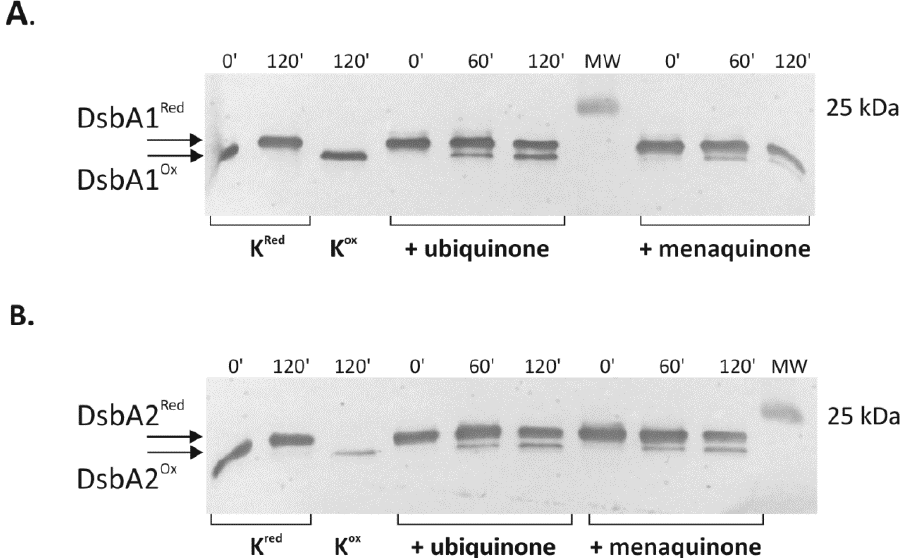
Figure 11. Western blot analysis of the CjDsbA1 ( A ) and CjDsbA2 ( B ) redox state in the presence of CjDsbB. The reoxidation of CjDsbA1 ( A ) or CjDsbA2 ( B ) by CjDsbB was performed in the presence of ubiquinone or menaquinone. The reaction was monitored over time by AMS trapping. Proteins were separated in 16% polyacrylamide gels with the addition of sucrose under reducing conditions and then detected by Western blot analysis using anti-CjDsbA1 antibodies ( A ) and anti-CjDsbA2 antibodies ( B ). The experimental conditions are described in Materials and Methods Section. Lanes marked “K red ” and “K ox ” indicate samples of reduced or oxidized DsbA1 ( A ) or DsbA2 ( B ). Lane marked MW contains molecular weight marker. Abbreviations: red—reduced; ox—oxidized.